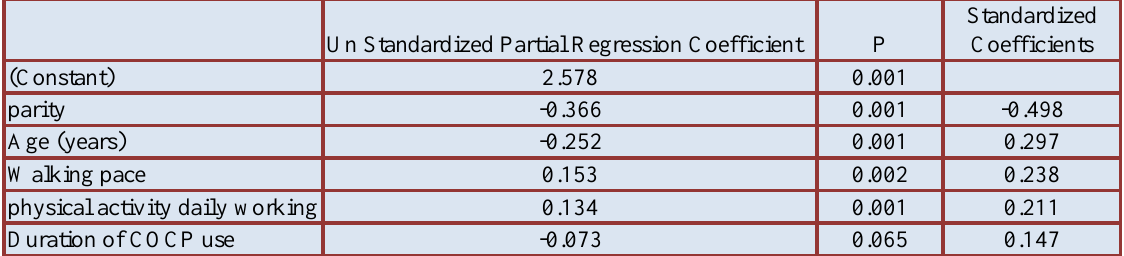
Fig 5: Error bar chart showing the difference in cortical thickness and BMD in mental and gonial angle between the two study groups. Table 2: The effect of COCP on cortical thickness of Gonial angle after adjusting with other explanatory variable.